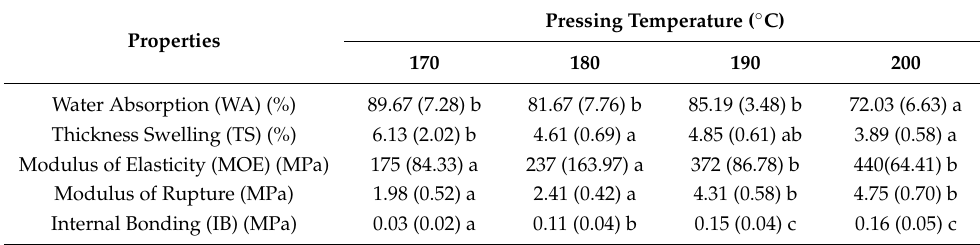
Table 2. Properties of TTBSB-particleboards at different pressing